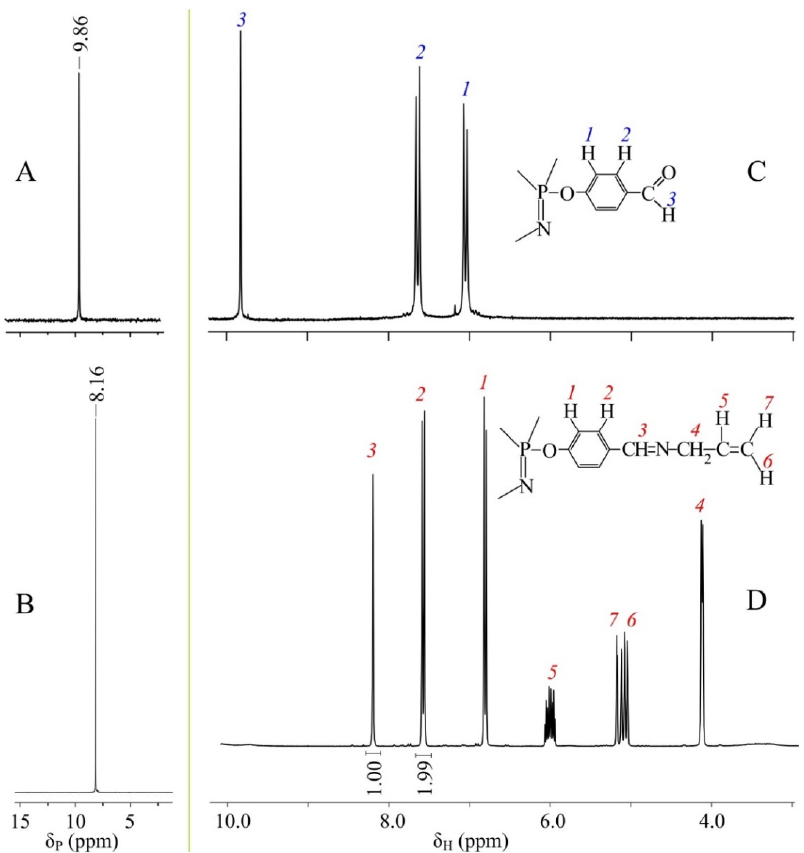
Figure 2. 31 P NMR spectra FPP ( A ) and APP ( B ) and 1 H NMR spectra of FPP ( C ) and APP ( D ).